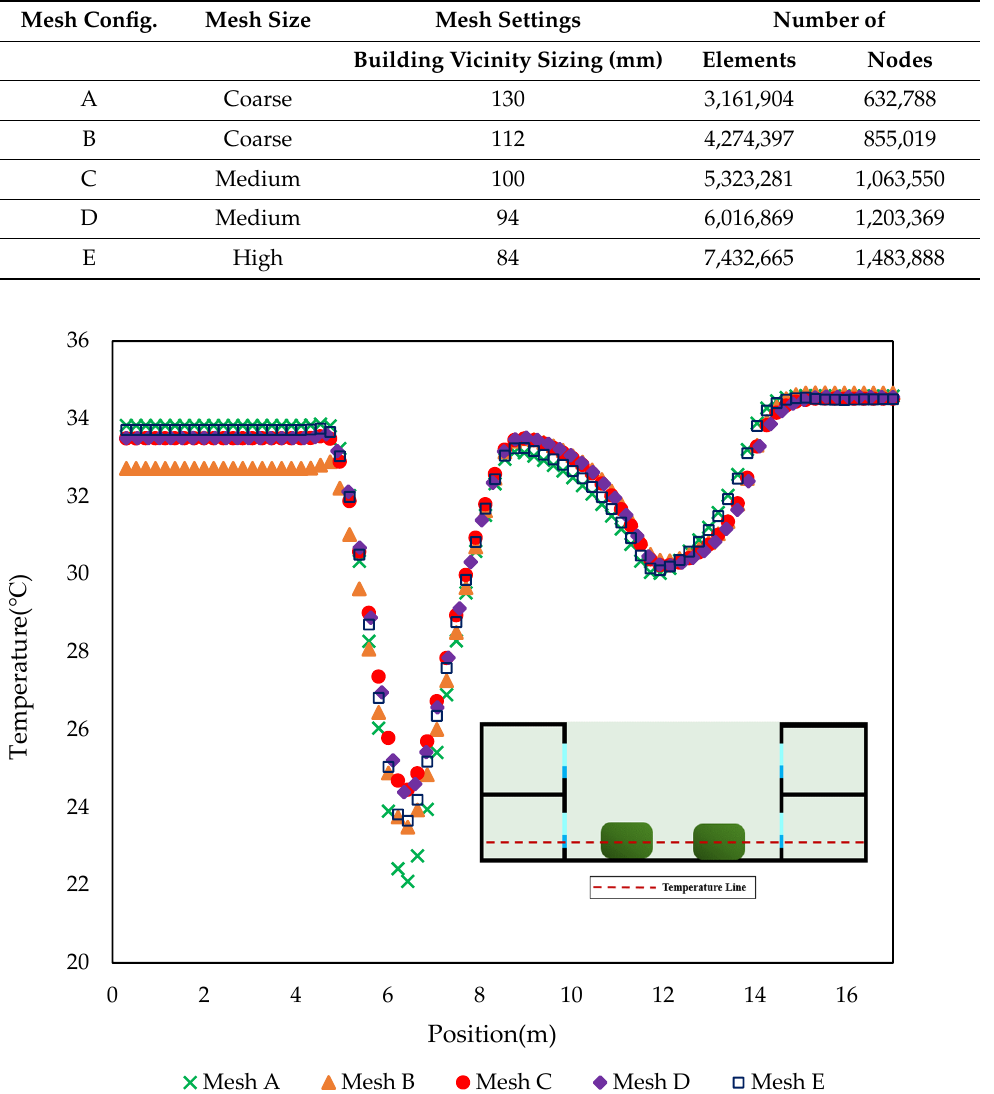
Figure 9. Simulated results of temperature along a horizontal center line of the courtyard model with small trees at the height of 0.7 m for the grid sensitivity analysis.